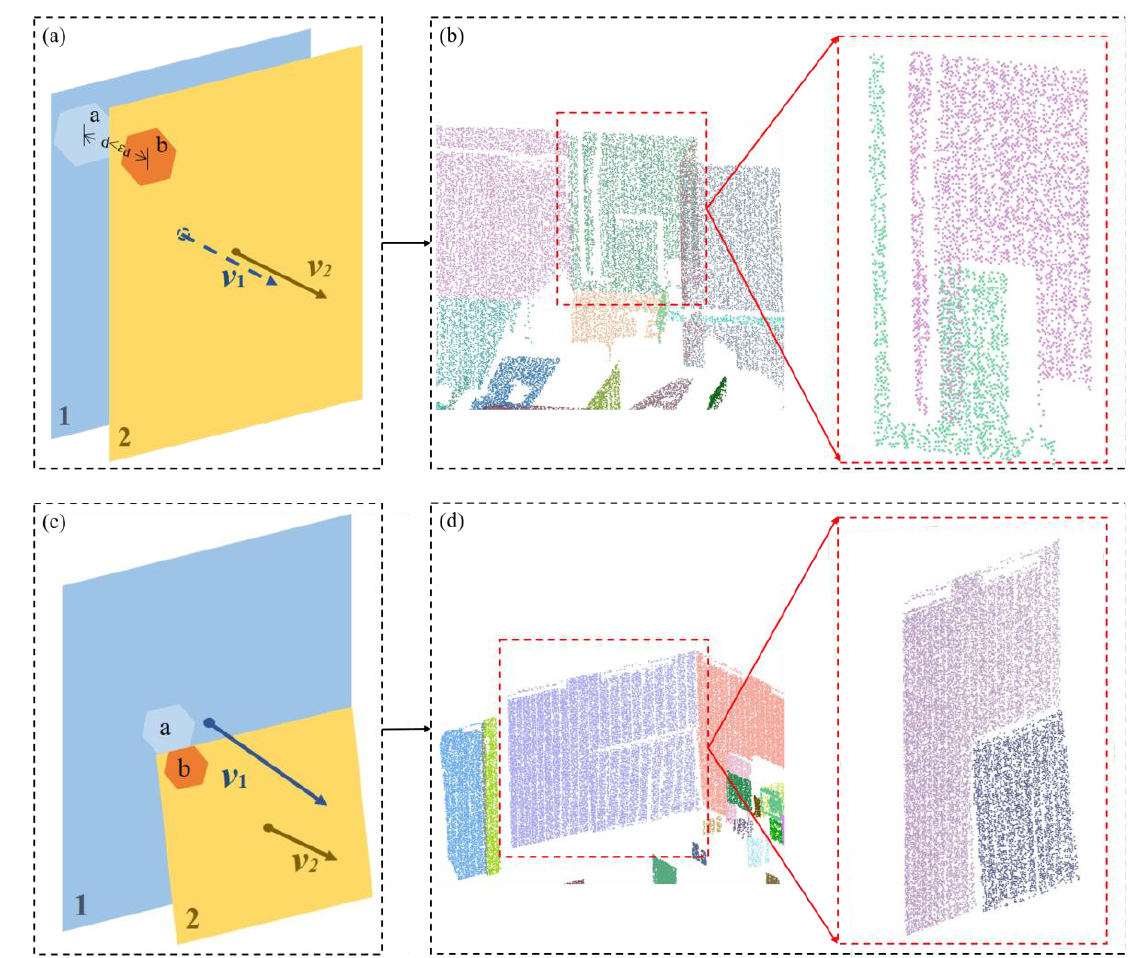
Figure 6. Examples to illustrate two types of problems for the instantiation: ( a ) and ( b ) a pair of close parallel planes; ( c ) and ( d ) lack of discrimination between planes.